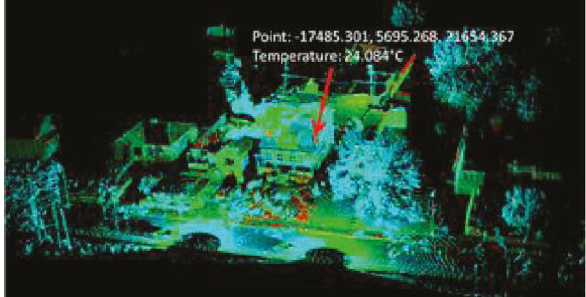
Figure 10: The point cloud of the building including the thermal